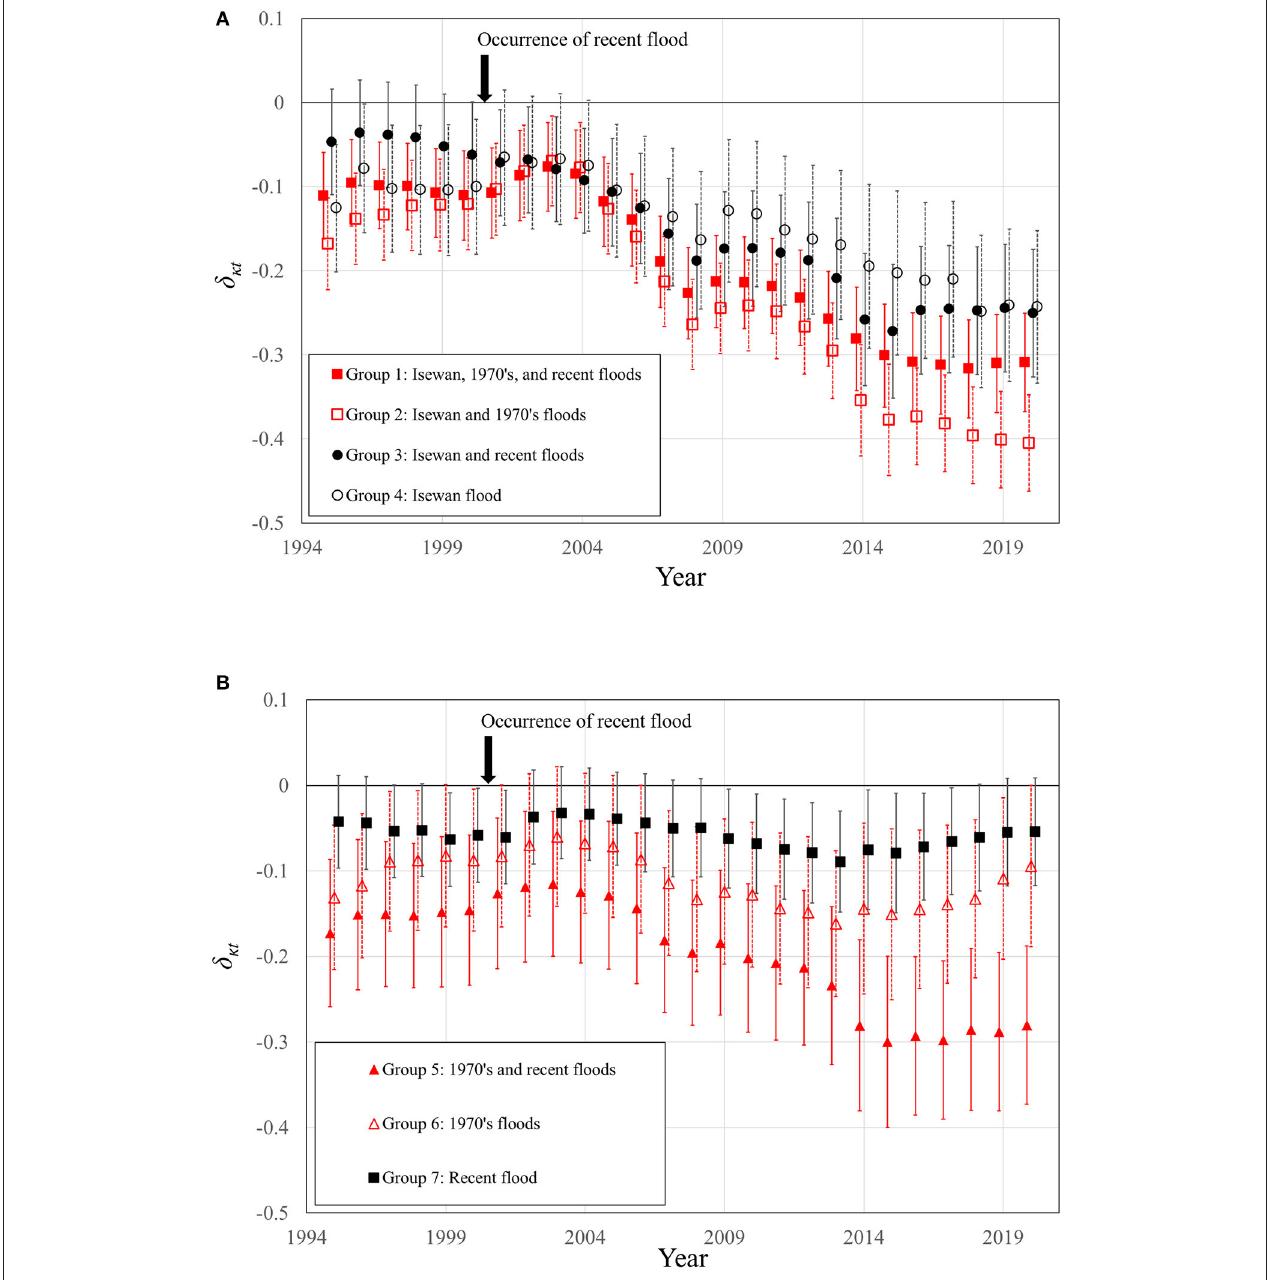
FIGURE 4 | Estimated parameters of the devaluation of properties in seven groups compared with properties that were not inundated in the Isewan, 1970’s, or recent floods. (A) Groups 1–4. (B) Groups